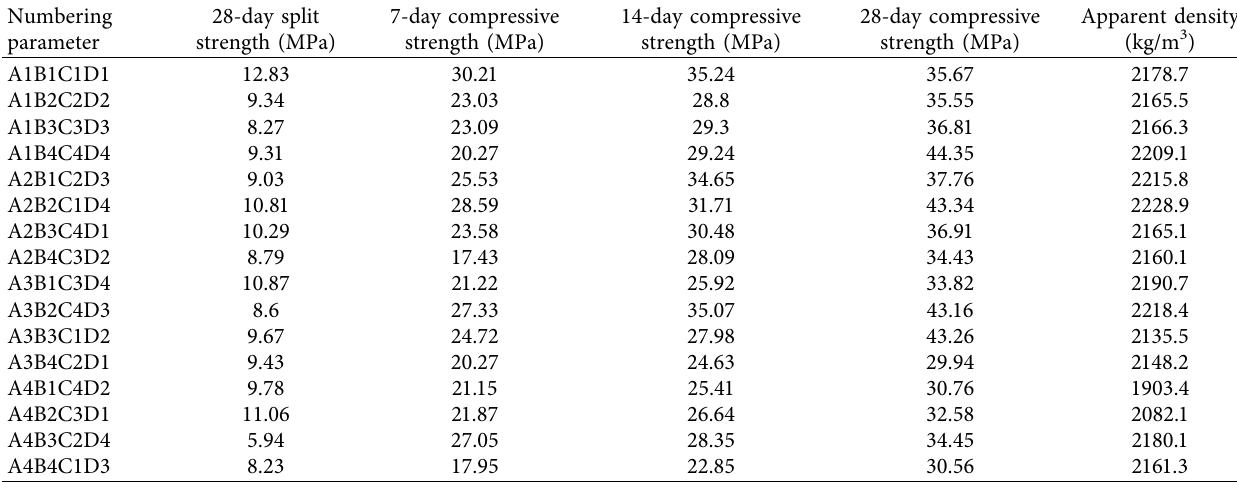
Table 2: Orthogonal test results.